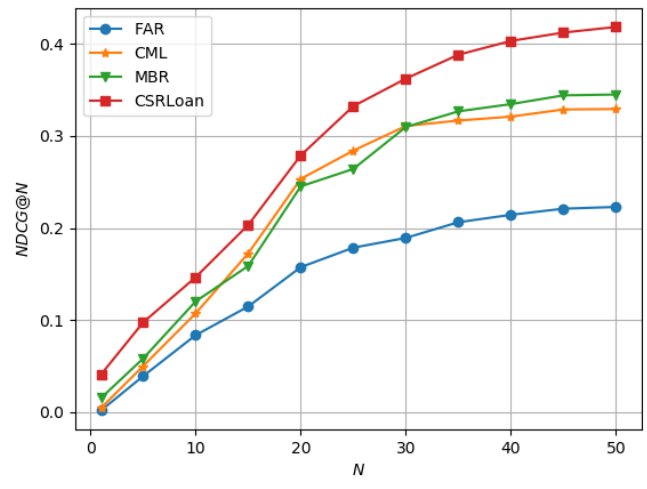
Figure 4. NDCG@N of loan recommendation where N ranges from {1, 5, 10, 15, ..., 45,